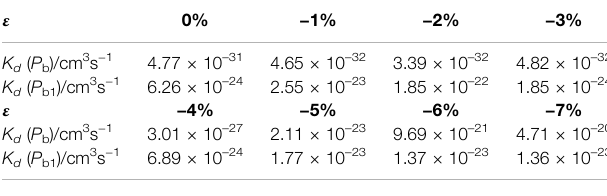
TABLE 9 | Depassivation reaction rates of P b and P b1 defects under compressive strains at 300 K.